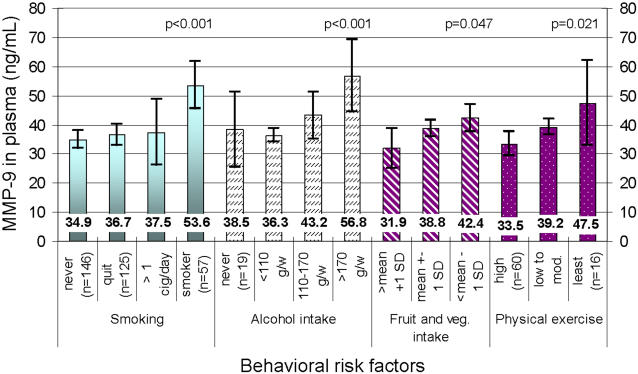
MMP-9 in relation to ordinal categories of smoking, alcohol intake, fruit and vegetable intake and physical exercise, respectively.Mean and 95% confidence intervals.